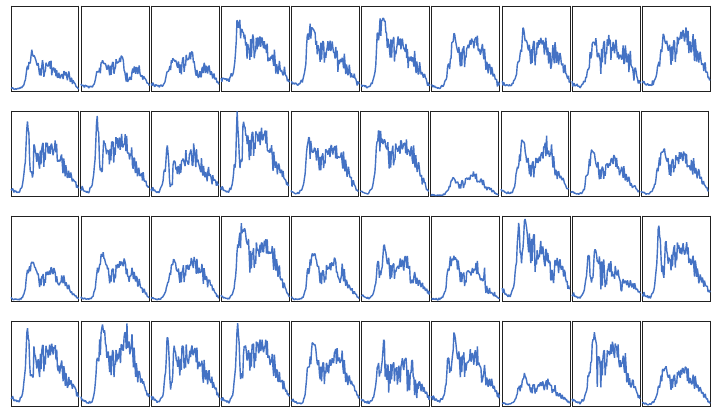
Figure 6. Illustration of traffic flow profiles from 40 sensors in the same day.